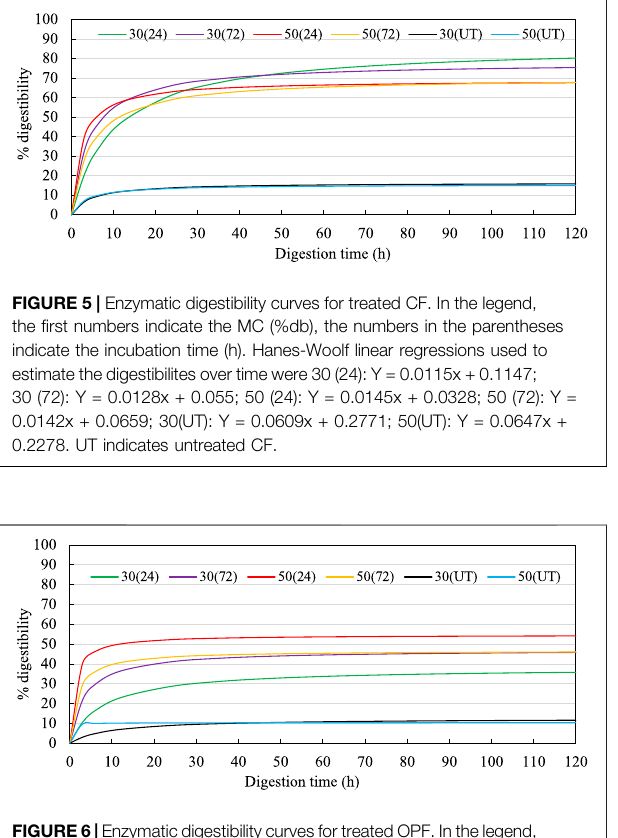
TABLE 6 | p -values of main and interaction effects on enzymatic digestibilities of the LMAA-treated biomass. Factor DDGS Incubation time